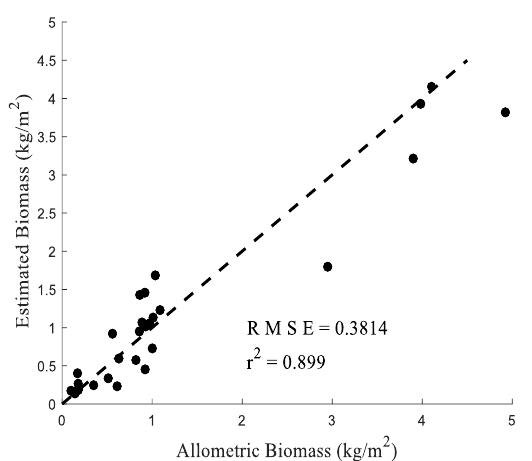
Figure 6 . Validation of the MPRVI based biomass